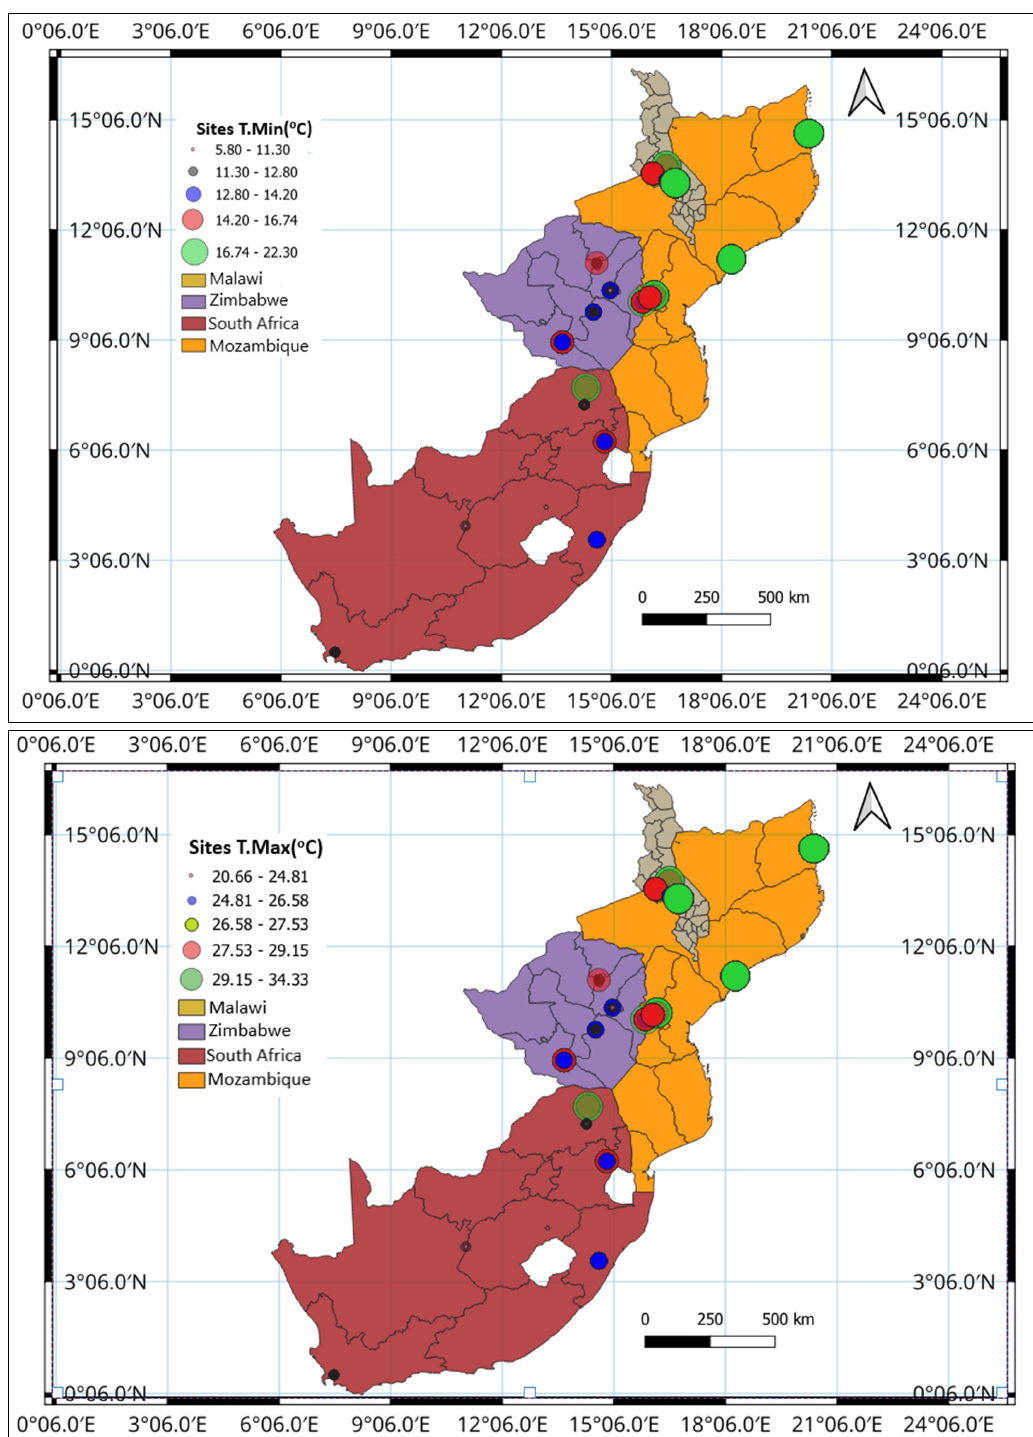
Figure 1. Maps of part of southern Africa showing average minimum and maximum temperatures of the meteorological stations used in the study. Table 1. Location-related information of the meteorological stations and time period of the temper- ature data sets used in the study in the four southern African countries.